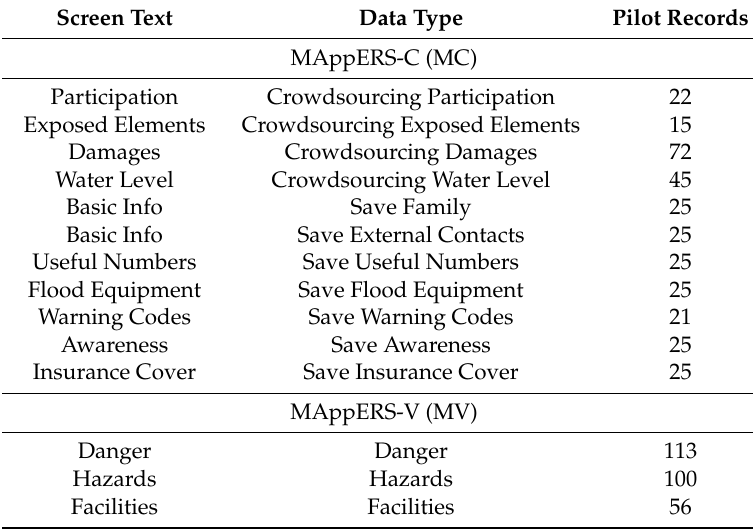
Table 1. Data collected with first piloting experience